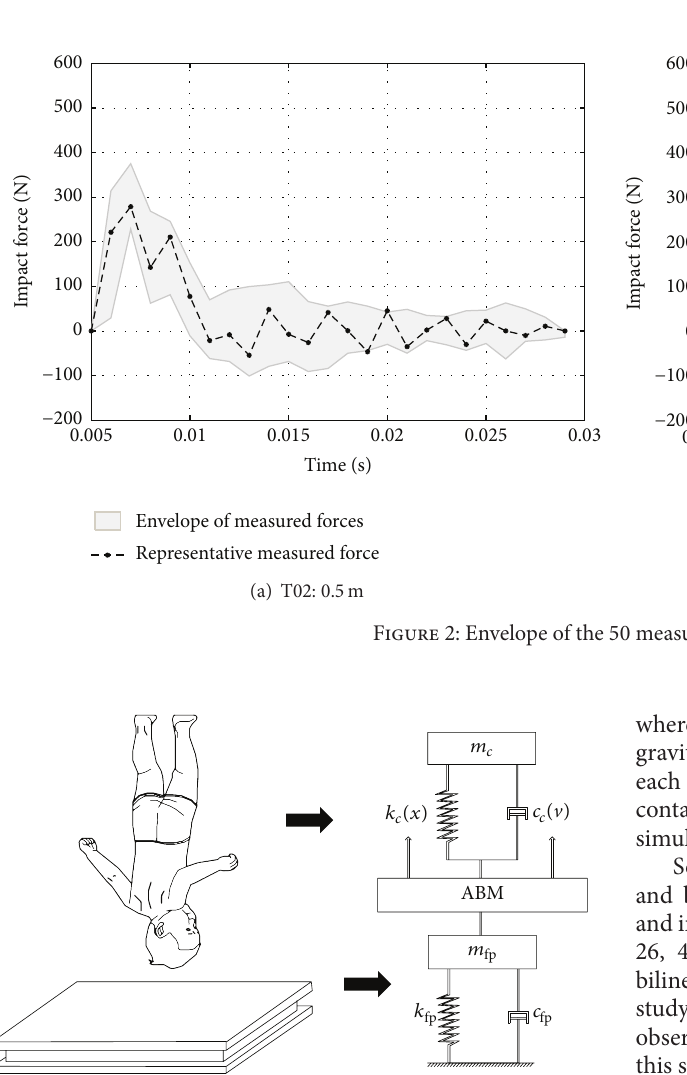
Figure 3: The schematic of the child-force plate model featuring agent-based model (ABM) at the interface between the body and force